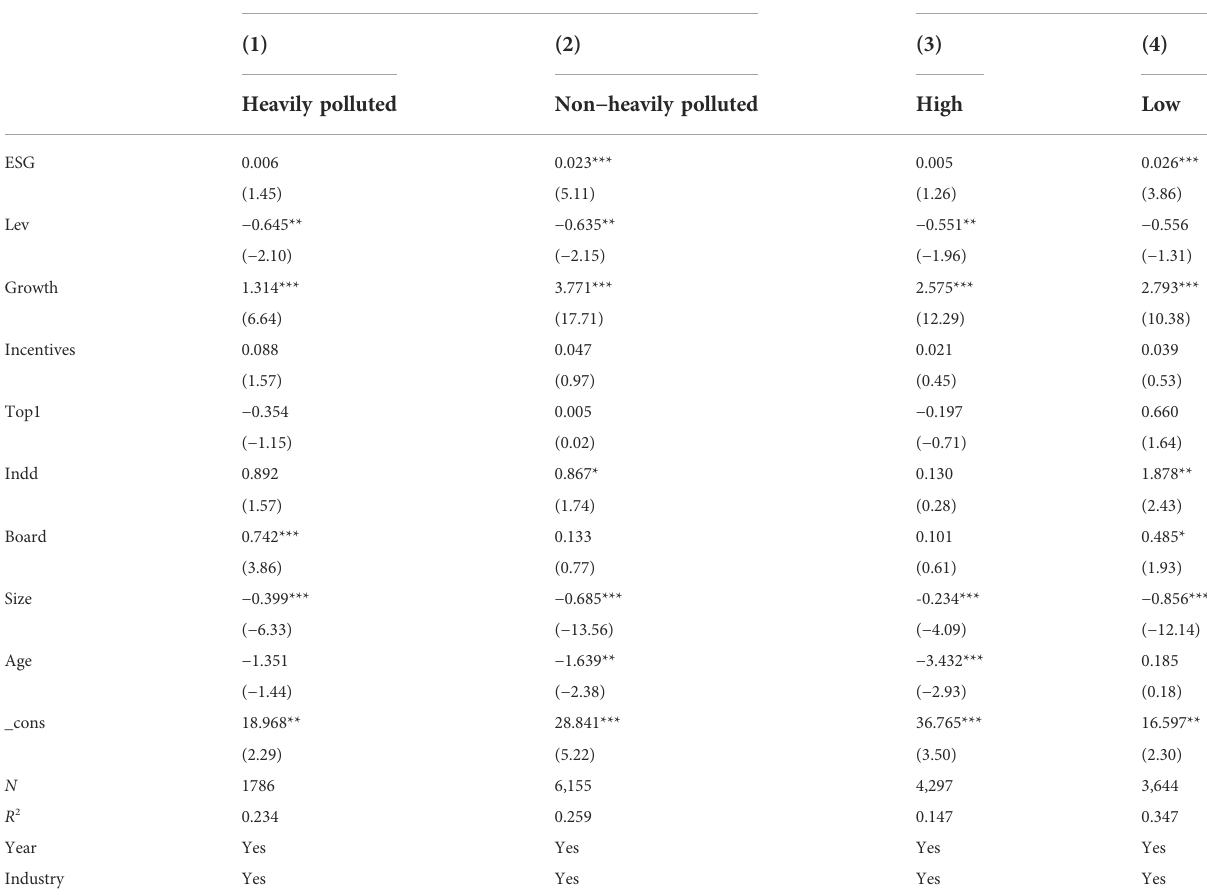
TABLE 8 Heterogeneity